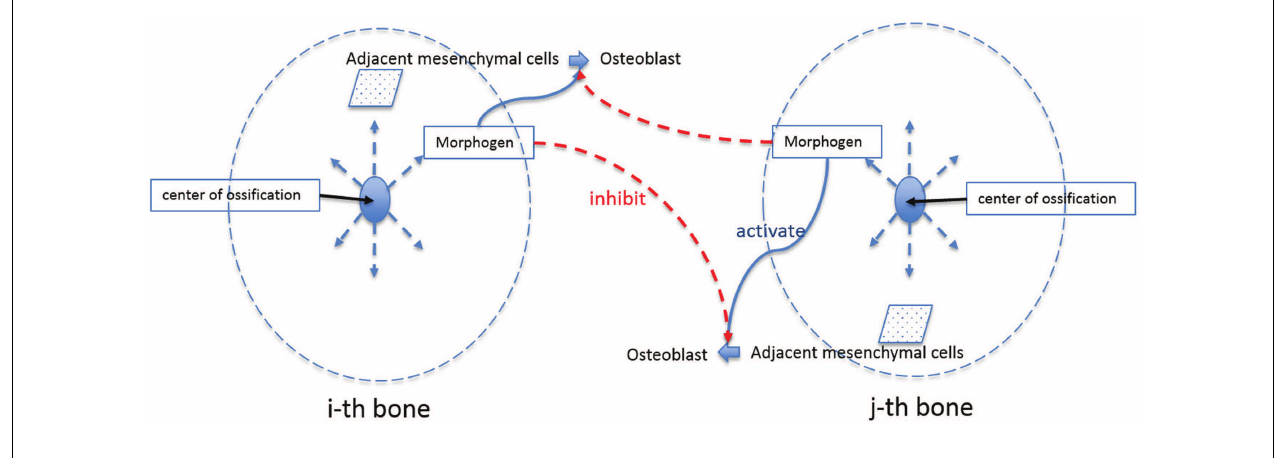
osteoblasts. Suture formation between bone elements is modeled by assuming that differentiation of mesenchymal cells adjacent to bone is restricted by the morphogen secreted from the adjacent bone elements.